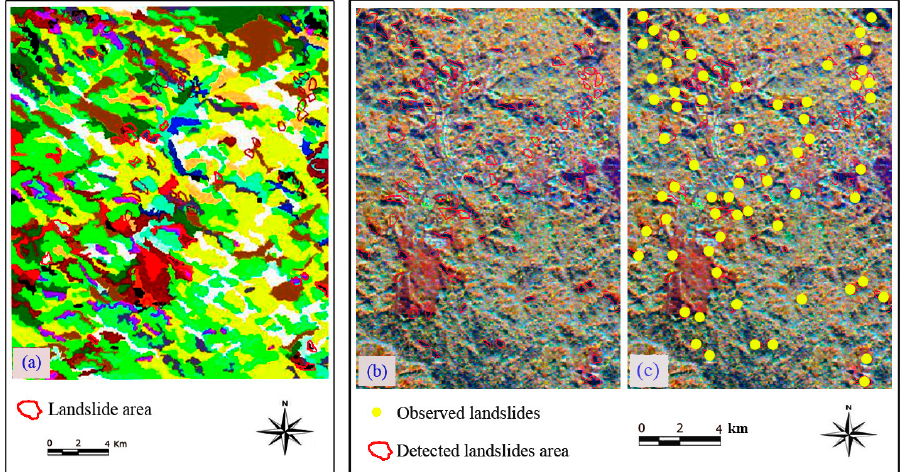
Figure 6. The AIRSAR composite image is overlaid onto the old landslides map: ( a ) the segmented and classified AIRSAR images overlaid with the old landslide map (landslides in red polygons), ( b ) detected landslides and ( c ) comparing detected and observed landslides.